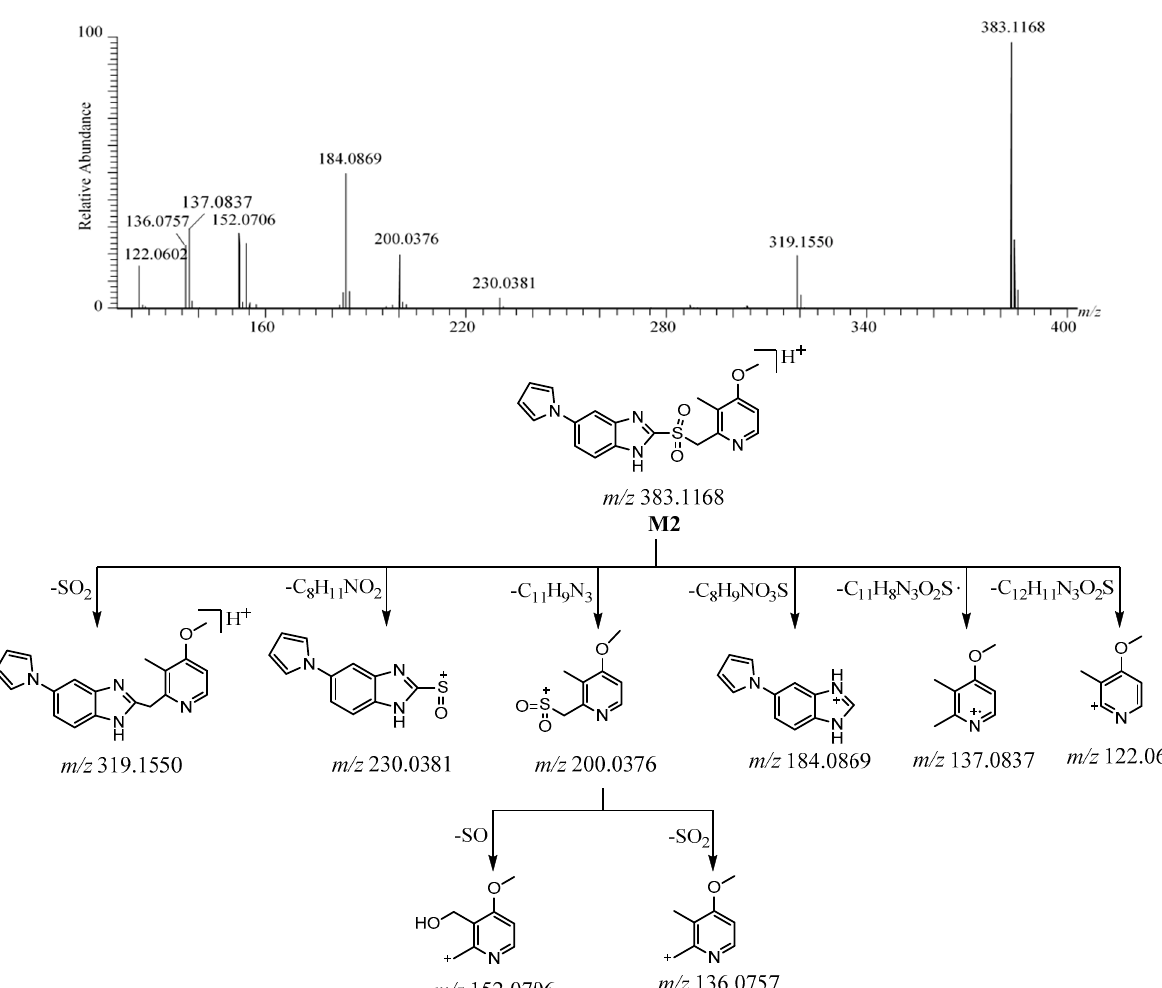
Figure 5. The HRMS/MS spectrum and the possible fragmentation pathway of M2.